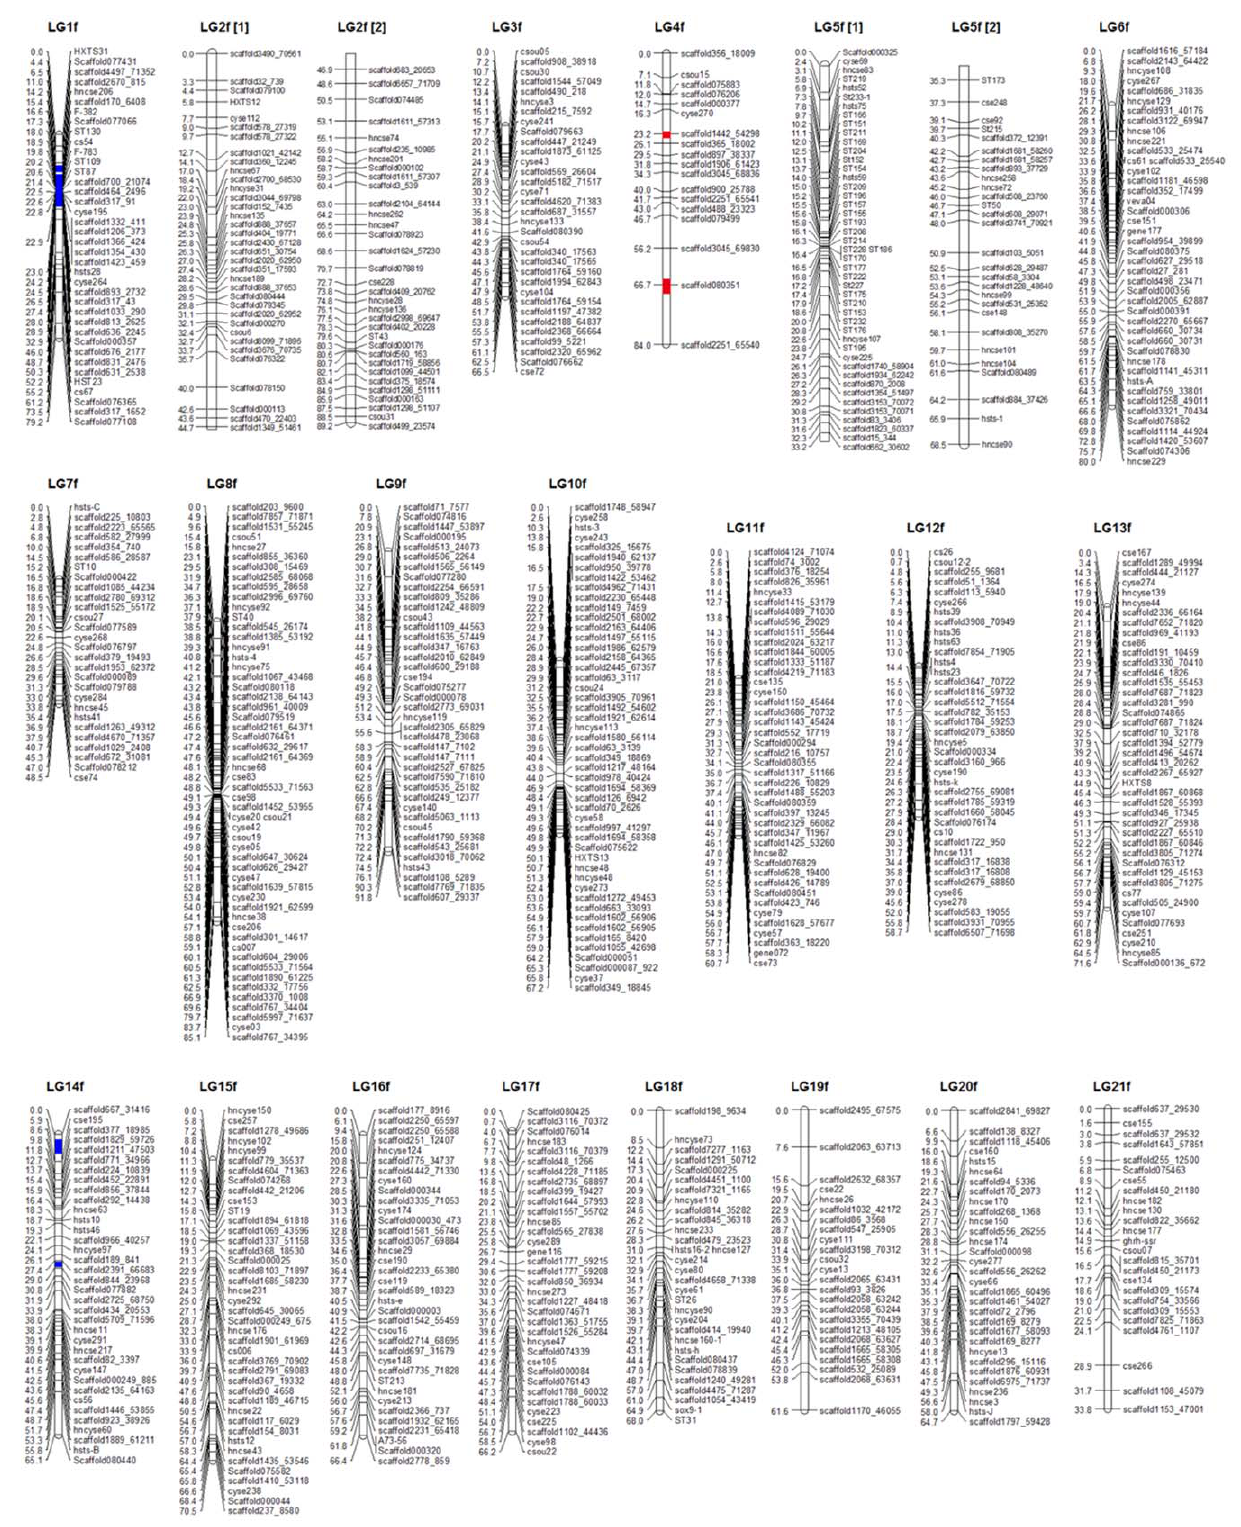
Figure 2. Linkage maps of the female-specific map for Cynoglossussemilaevis . The female-specific genetic map comprises 828 markers assigned to 21 linkage groups (LG1f–LG21f). Genetic distances in Kosambi centimorgans are listed on the left side of the linkage groups, and markers are listed on the right side of the linkage groups.